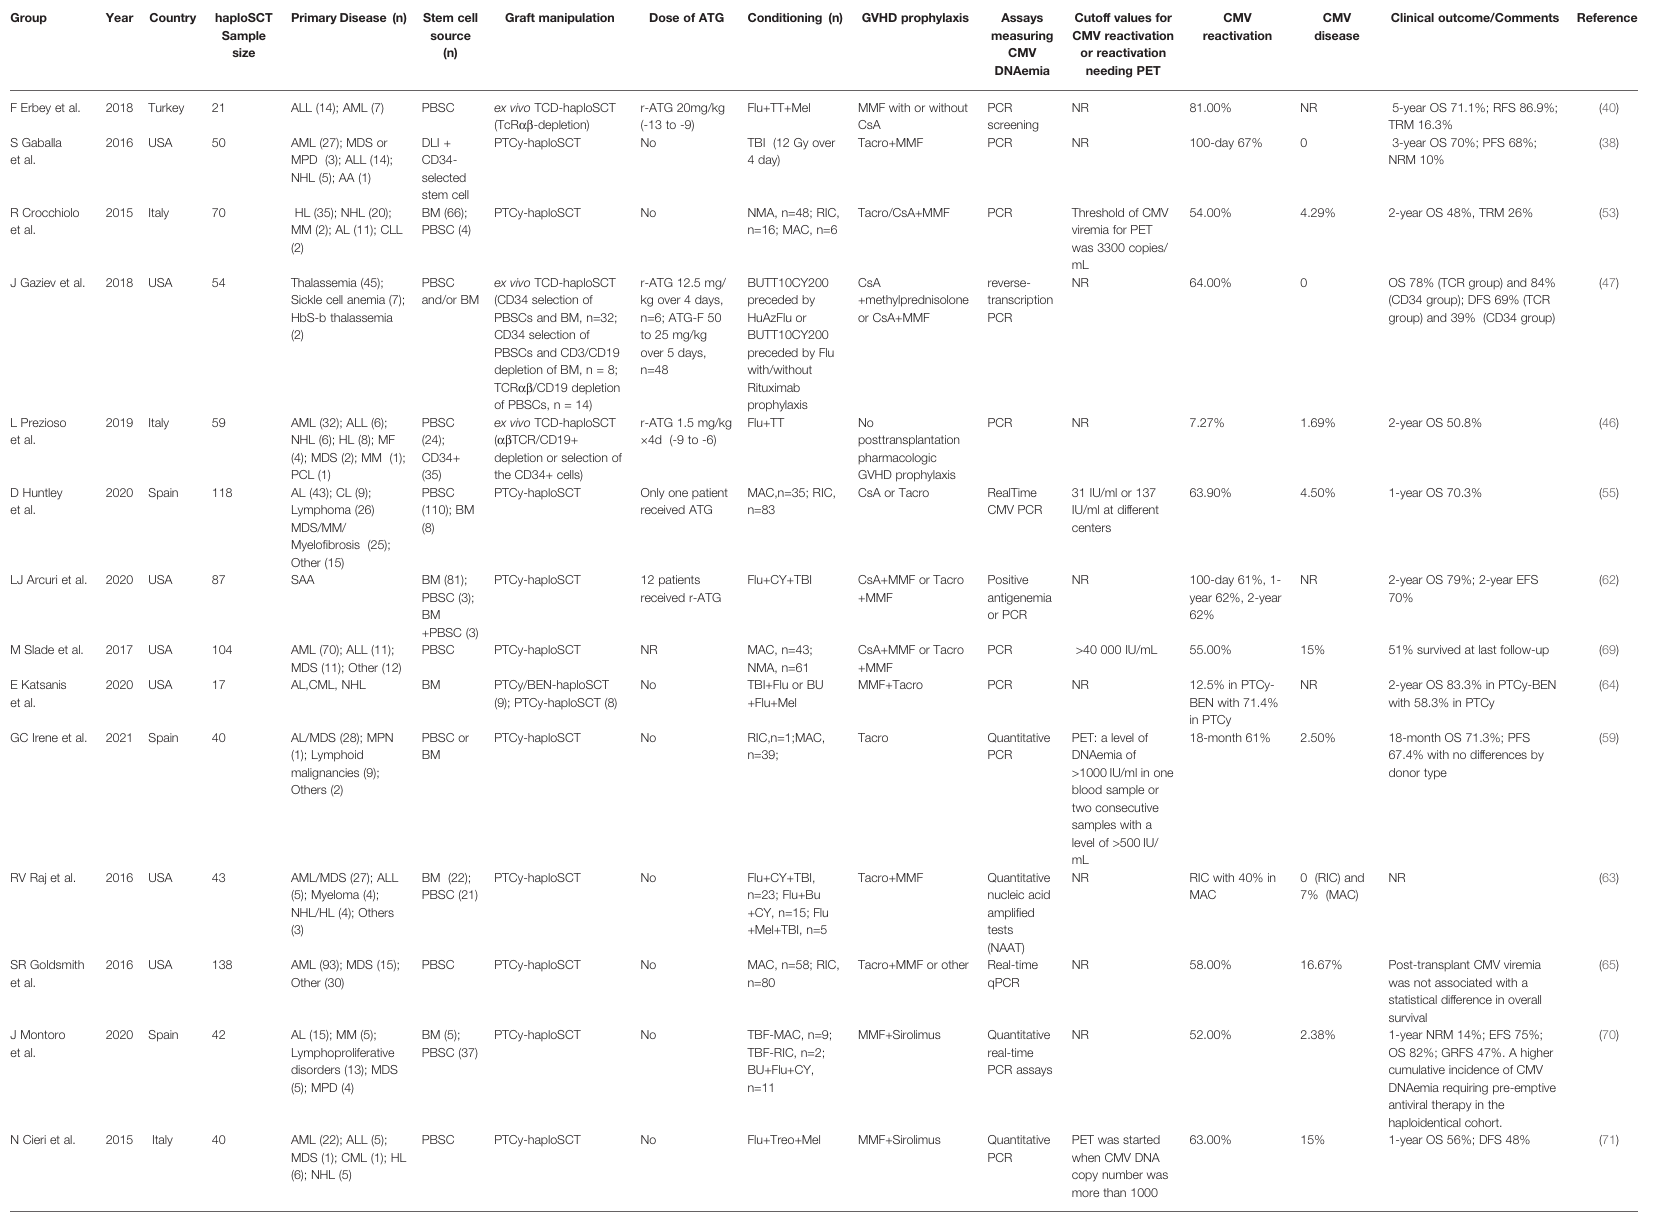
Quantitative PCR